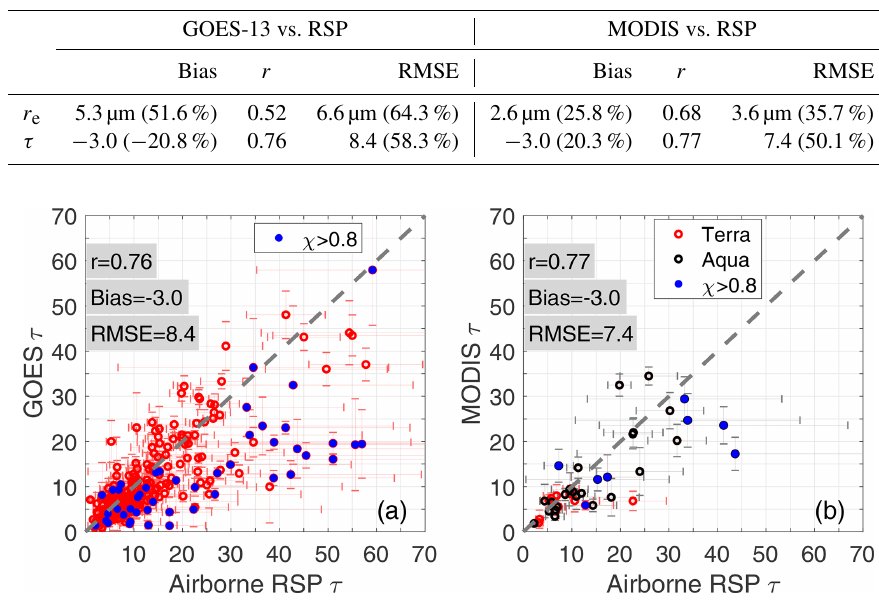
Table 2. General r e and τ statistics between satellite and RSP retrievals. Percentage values are relative to mean RSP values matched with the satellite data.